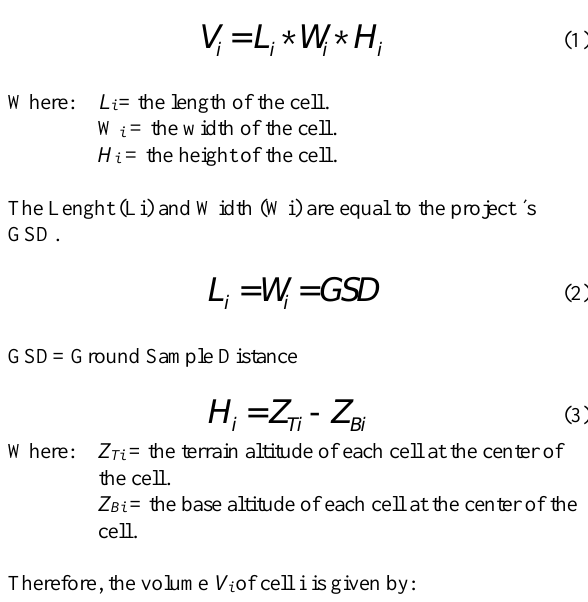
Figure 6, where the bar graph of measured volume with UAV data has the error bar